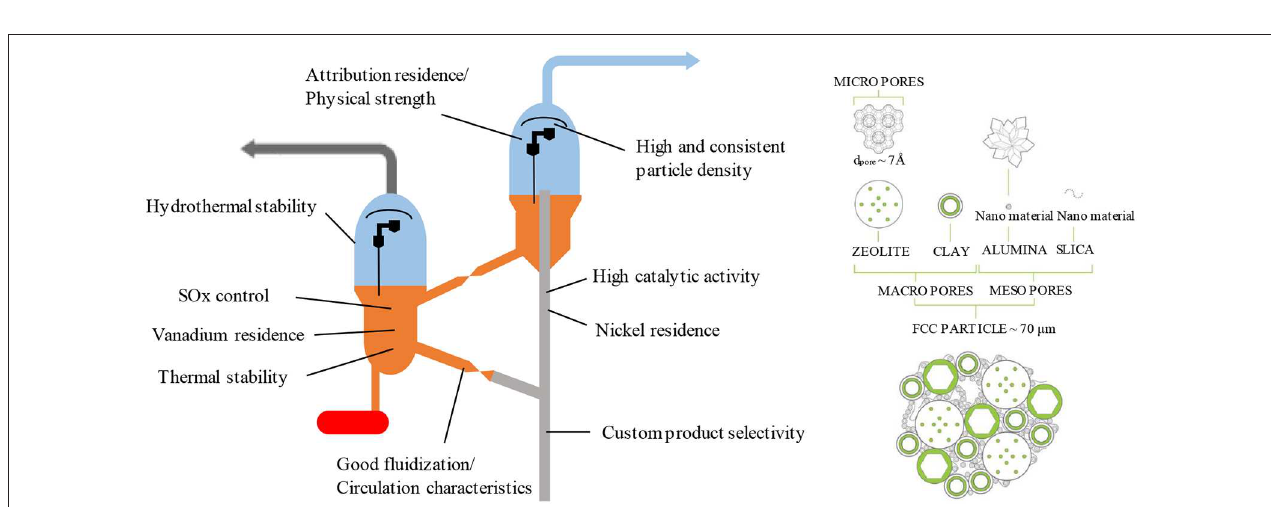
FIGURE 3 | Catalyst properties required for an FCC unit (left), adapted from Rawlence and Gosling (1988) with permission from Elsevier and typical chemical and structural composition of an FCC particle (right) reprinted from Vogt and Weckhuysen (2015) with permission from the Royal Society of Chemistry (RSC) under the Creative Commons CC BY